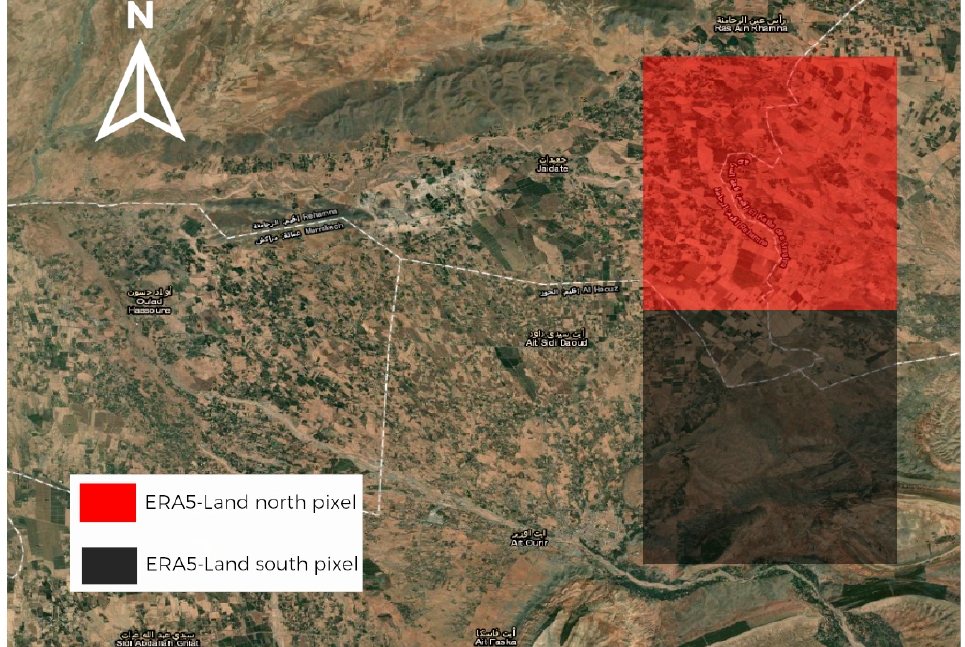
Figure 3. The projection of ERA5-Land pixels over the study